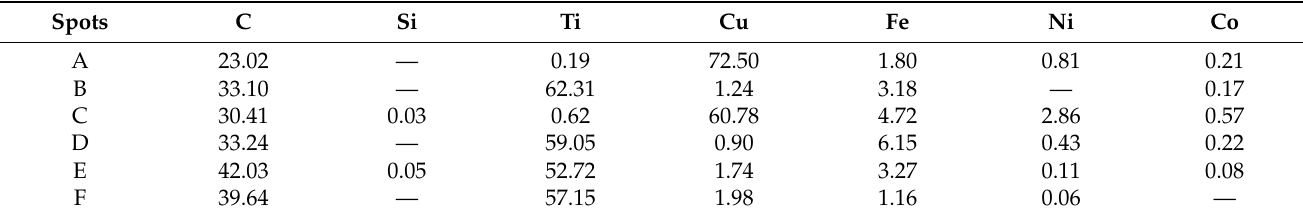
Table 6. Component content of each point in Figure 11 (at.%).